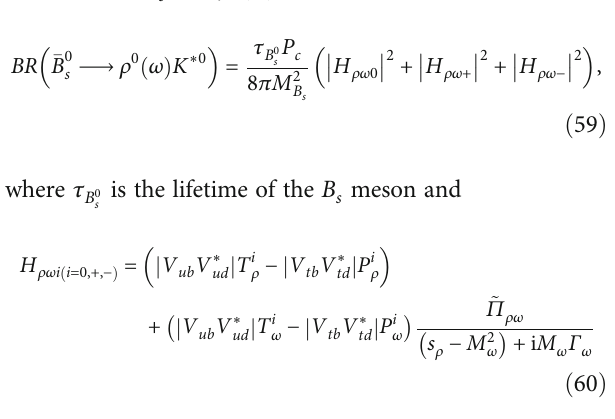
6.1. CP Violation via ρ − ω Mixing in ⟶ π + π − K ∗ 0 . We have investigated the CP violating asym- (cid:1) ⟶ ρ 0 ð ω Þ K ∗ 0 ⟶ π + π − K ∗ 0 of the , for the metry, A B 0 CP s three-body decay process in the perturbative QCD. The